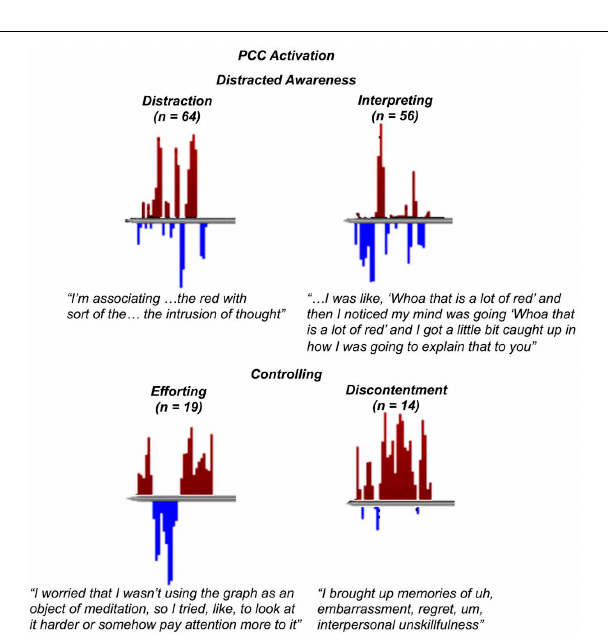
FIGURE 5 | “Distracted awareness” and “controlling” as basic eliciting factors of posterior cingulate cortex activation. Examples of self-report transcripts and feedback graphs for the theoretical codes leading to the basic eliciting factors of “distracted awareness” (top) and “controlling” (bottom)